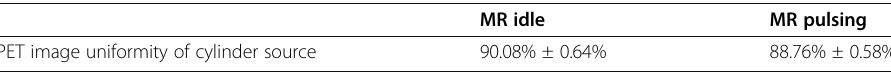
MR idle MR pulsing